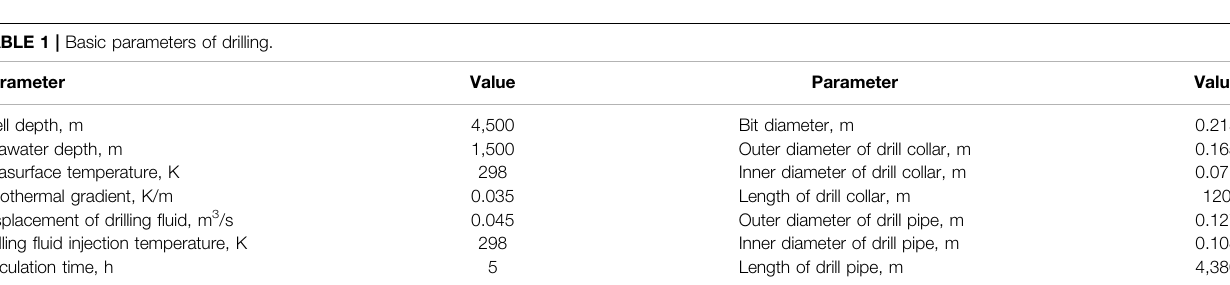
TABLE 1 | Basic parameters of